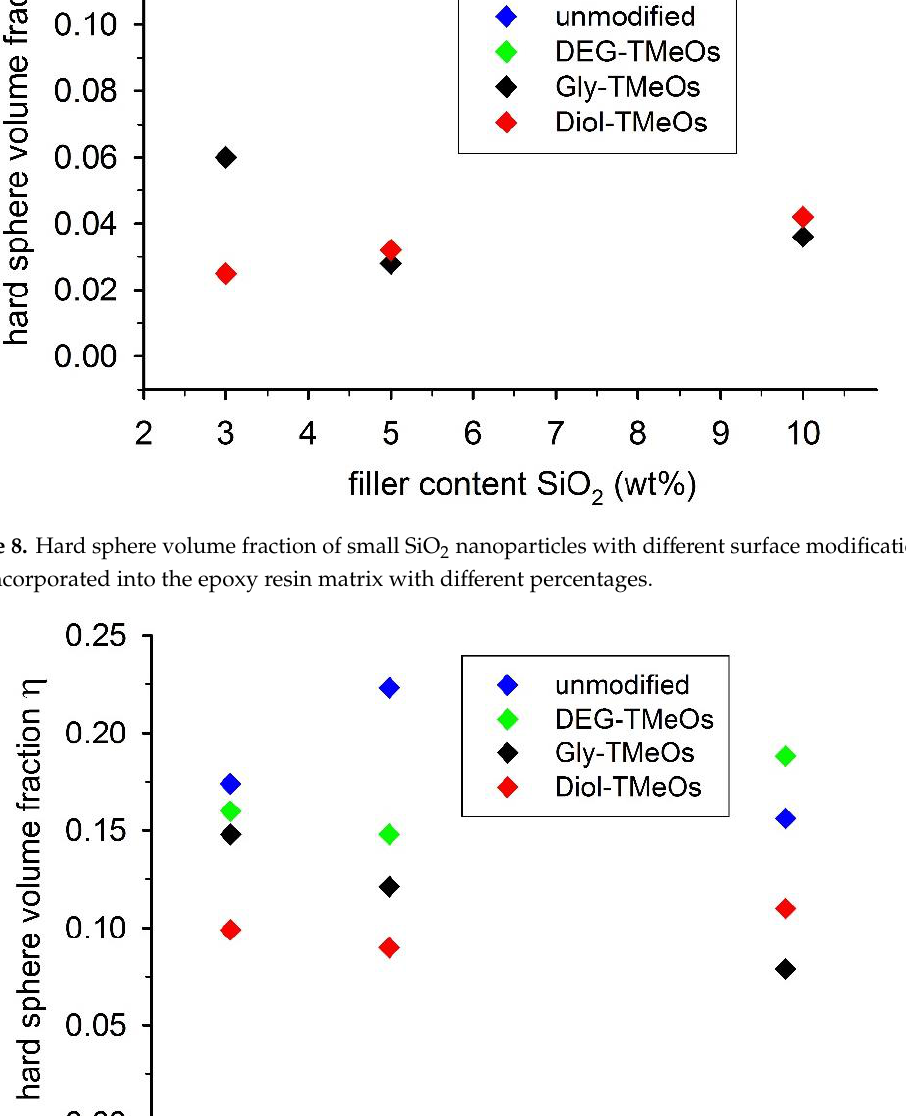
Figure 9. Hard sphere volume fraction of large SiO 2 nanoparticles with different surface modifications and incorporated into the epoxy resin matrix with different percentages.